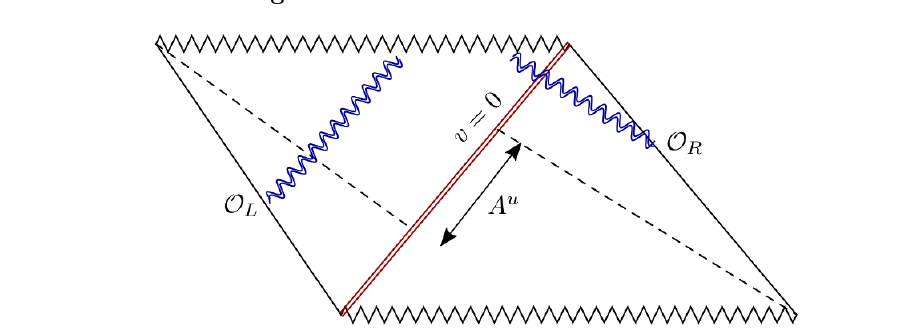
Figure 9 . Bound on information transfer.